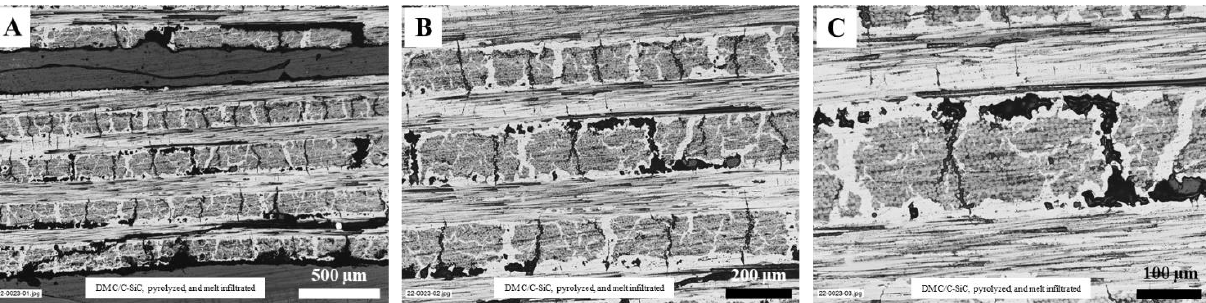
Figure 6. Optical images of a cross-section of pyrolyzed and Si-melt-infiltrated C/C-SiC composites, with increasing magnification ( A – C ).